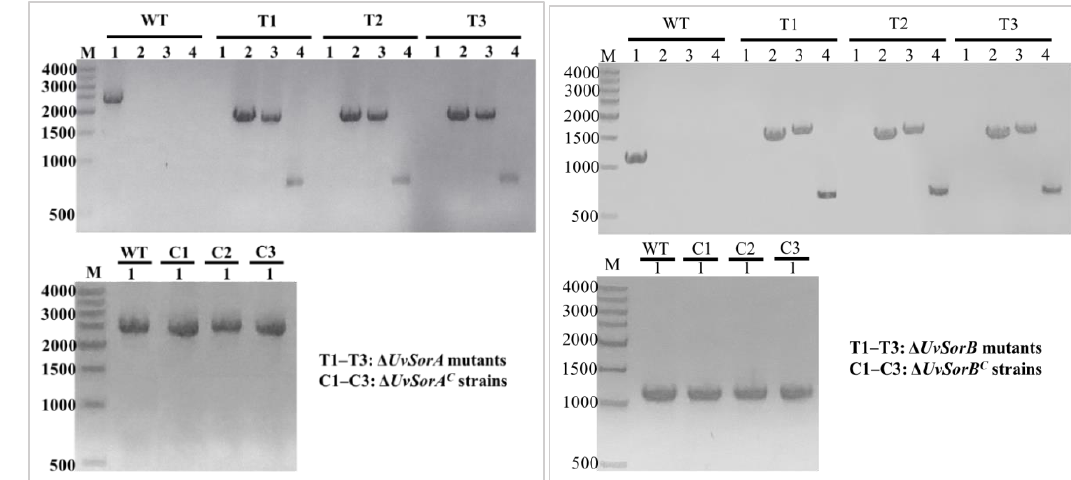
Figure 3. Generation of ∆ UvSorA and ∆ UvSorB mutants and their complemented strains of U. virens . ( A ) Schematic illustration of disruption and complementation of the target gene ( UvSorA or UvSorB ). ( B ) In the Δ UvSorA mutant, the specific bands (1800, 1772 and 687 bp) were only detected in the mutants (T1 – T3) but not in WT strain. The specific band (2387 bp) was detected in Δ UvSorA C strains (C1 – C3) (left panel); In the Δ UvSorB mutants, the specific bands (1532, 1634 and 687 bp) were only detected in the mutants (T1 – T3) but not in WT strain. The specific band (1172 bp) was detected in Δ UvSorB C strains (C1 – C3) (right panel). Lane M: 500 bp DNA Ladder.